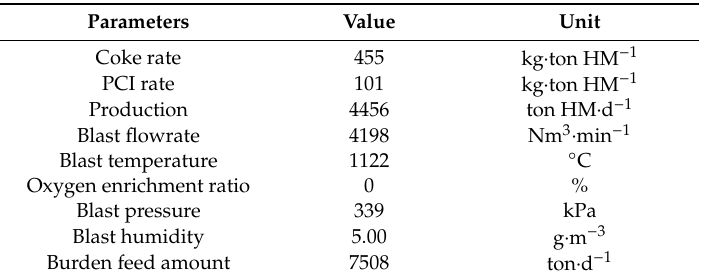
Table 2. Main operational parameters of the blast furnace.